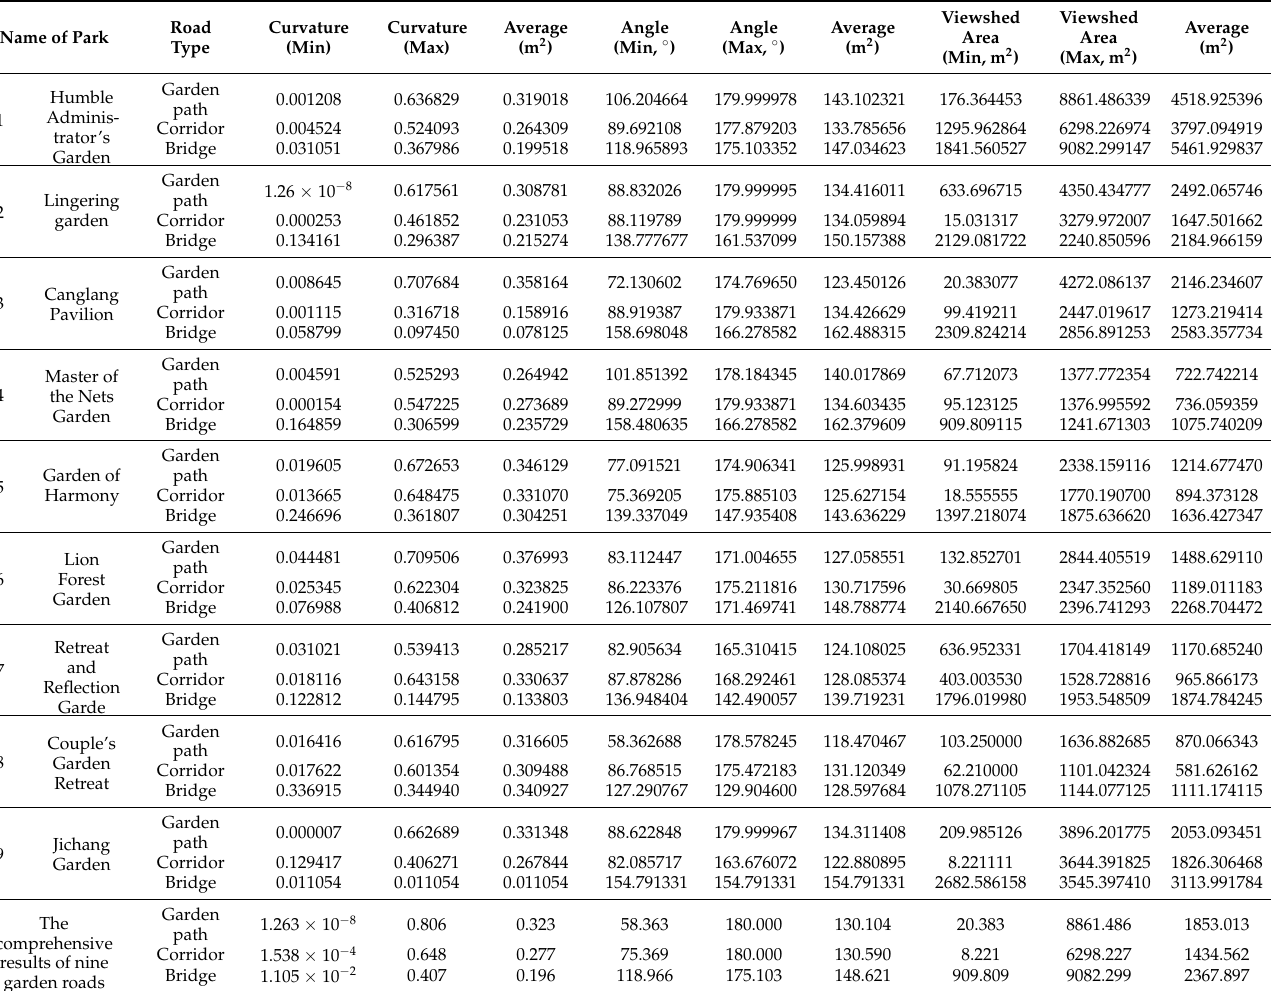
Table A1. Summary of nine garden